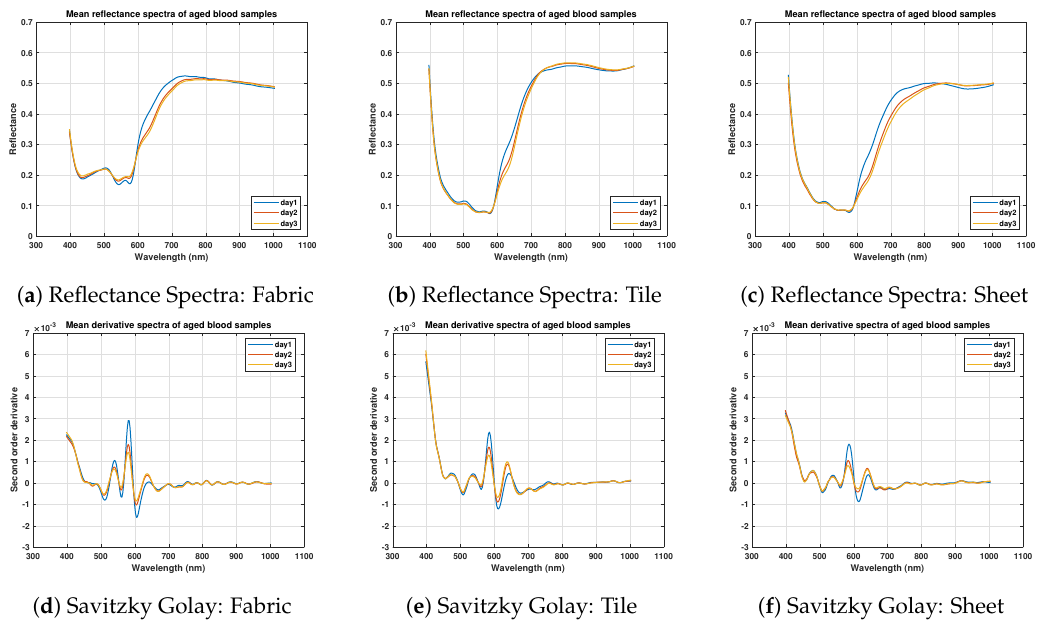
Figure 5. Mean reflectance spectra of aged blood samples of donor 1 and Savitzky Golay second order derivative spectra comparison over white fabric, white tile, and wall